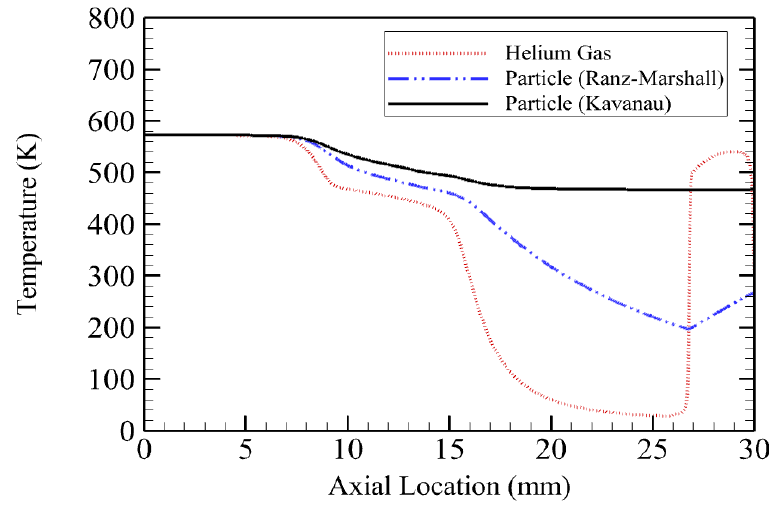
Figure 16. Effect of Nusselt number correlation on centerline particle temperature, d p = 5 µ m.